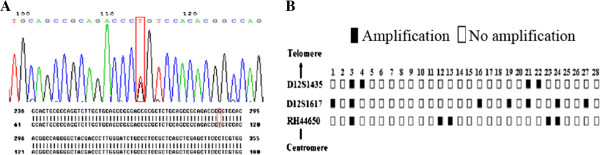
Exon mutation and amplification of BCAT1. (A) BLAST analysis result of BCAT1 exon 1. The red box indicates SNP site (+78G/T) by DNA sequencing. (B) The amplification status of three BCAT1 microsatellite loci in NPC samples, showing that the amplification ratios for D12S1435, D12S1617 and RH44650 were 14% (4/28), 25% (7/28) and 17% (5/28), respectively, and the total ratio was 42.4% (12/28).